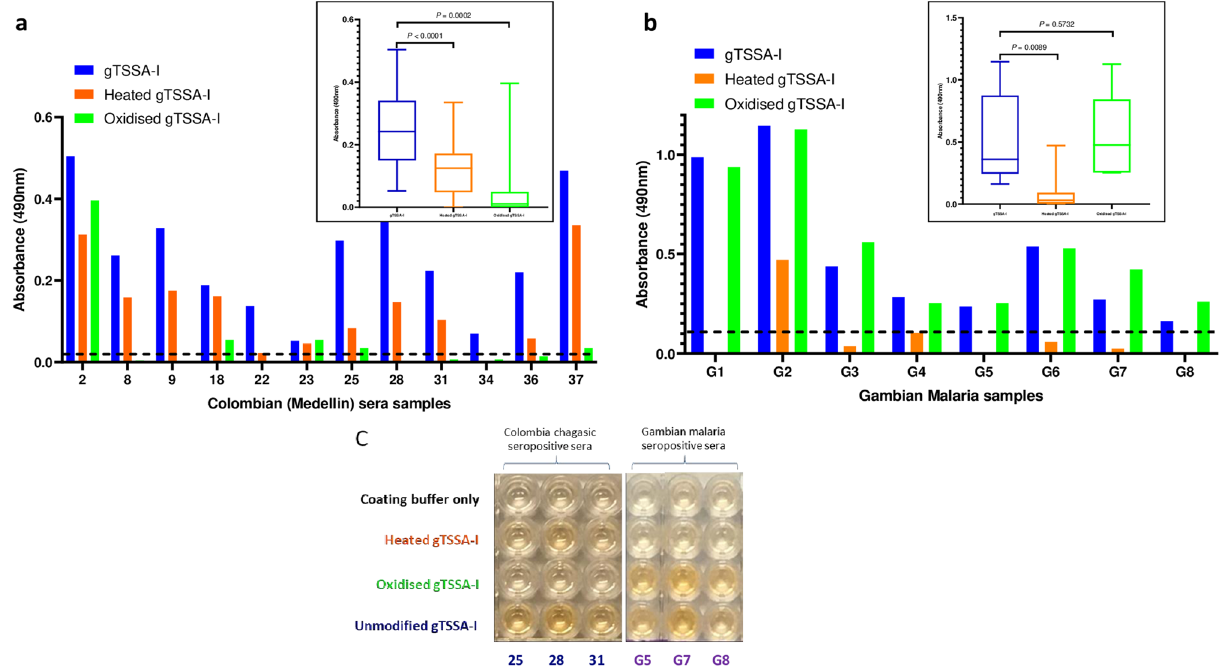
Figure 3. gTSSA-I antigenicity is dependent on glycosylation, whereas recognition by non-endemic malaria sera is dependent on structure. ( a ) Absorbance values of Colombian Medellín sera recognising unmodified gTSSA-I (blue bars), heat denatured gTSSA-I (orange bars) and oxidised gTSSA-I (green bars); oxidation decreases absorbance values substantially more than heat denaturing for all samples except 2. ( b ) Absorbance values of Gambian malaria (G) sera recognising unmodified gTSSA-I (blue bars), heat denatured gTSSA-I (orange bars) and oxidised gTSSA-I (green bars); heat denaturing decreases absorbance values substantially, whereas oxidation does not. For each of the data sets represented in ( a ) and ( b ) individual samples are presented on the main graph and composite absorbance values in the inset box-and-whisker plots. ( c ) ELISA plate illustrating the effects of modifications: coating with of unmodified gTSSA-I (fourth row); heat denatured gTSSA-I (second row), with slight signal reduction for Colombian sera but ablation for Gambian malaria sera; oxidised gTSSA-I (third row), with considerable reduction for Colombian sera, yet no reduction with Gambian malaria sera; coating buffer only (no antigen) control (first row). Sample numbers correspond with ( a ) and ( b